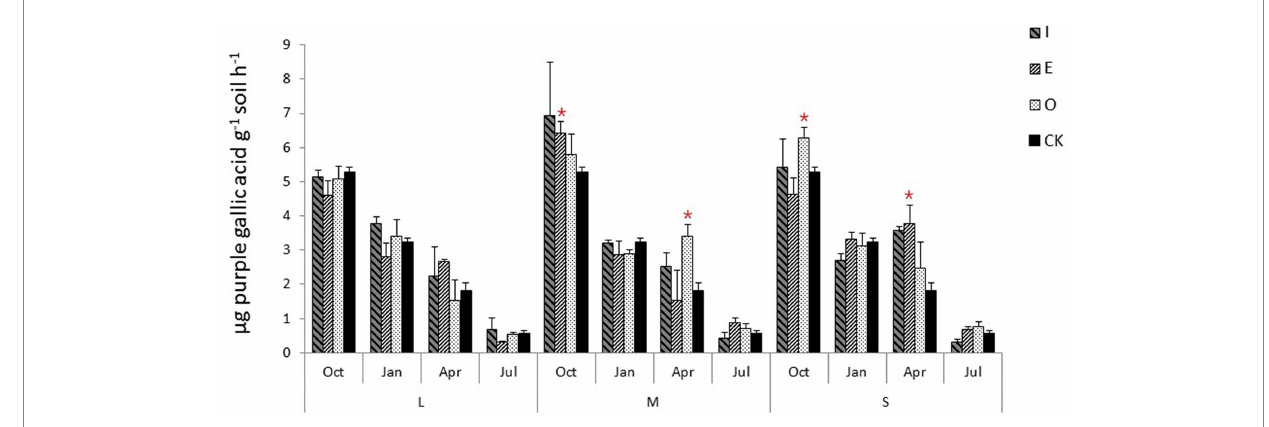
FIGURE 4 Soil peroxidase activity of different position in different sizes of gaps, the “*“signs represent significant differences.